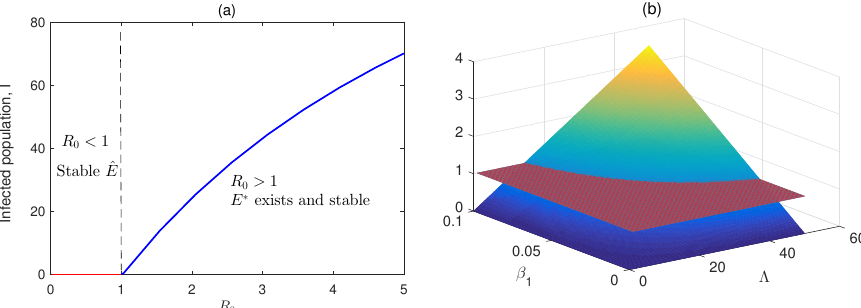
Figure 2. ( a ) The transcritical bifurcation diagram at R 0 = 1 is presented; ( b ) the value of the basic reproduction number ( R 0 ) is shown when the disease transmission rate ( β 1 ) and the virions production rate ( λ ) are varied simultaneously. Other parameter values are taken from Table